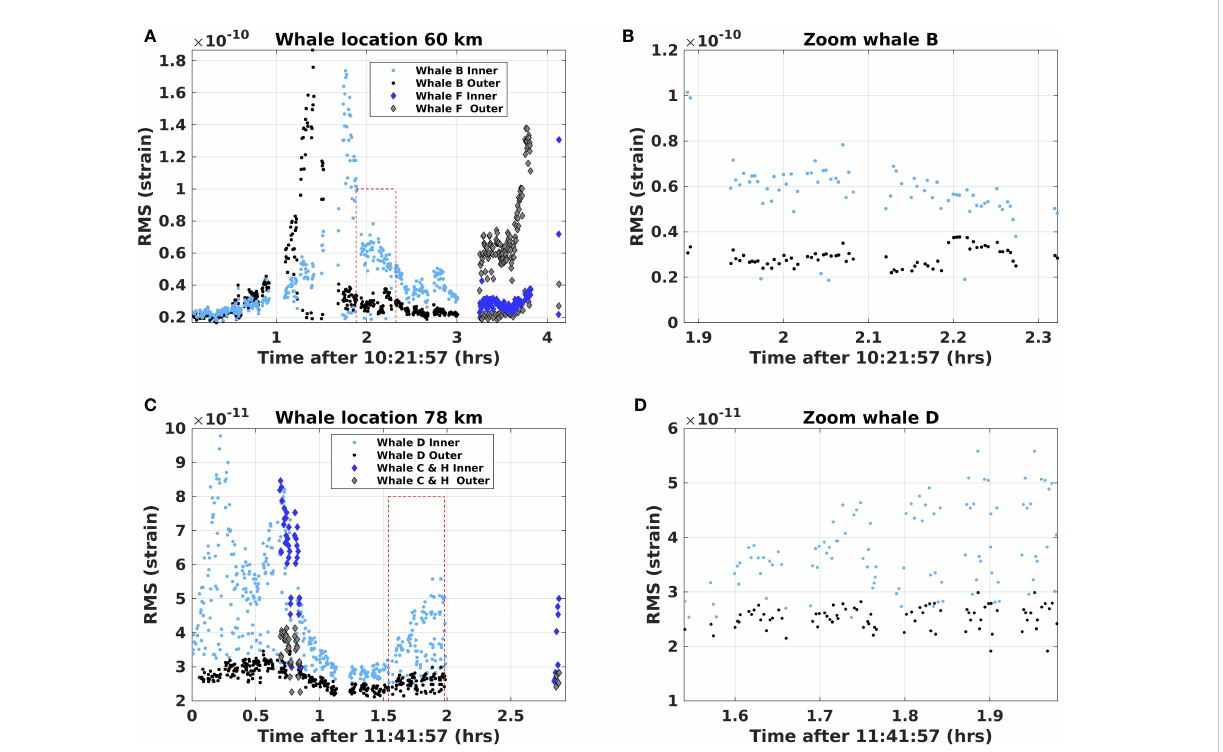
FIGURE 6 Observed RMS amplitudes of fi n whale vocalizations in whale locations 60 km and 78 km (see Figure 5) computed by a rectangular window around the calls. (A, C) All RMS levels from the vocalizations in the respective locations. (B, D) Zoomed-in versions to illustrate periods with whale calls and the inter-series